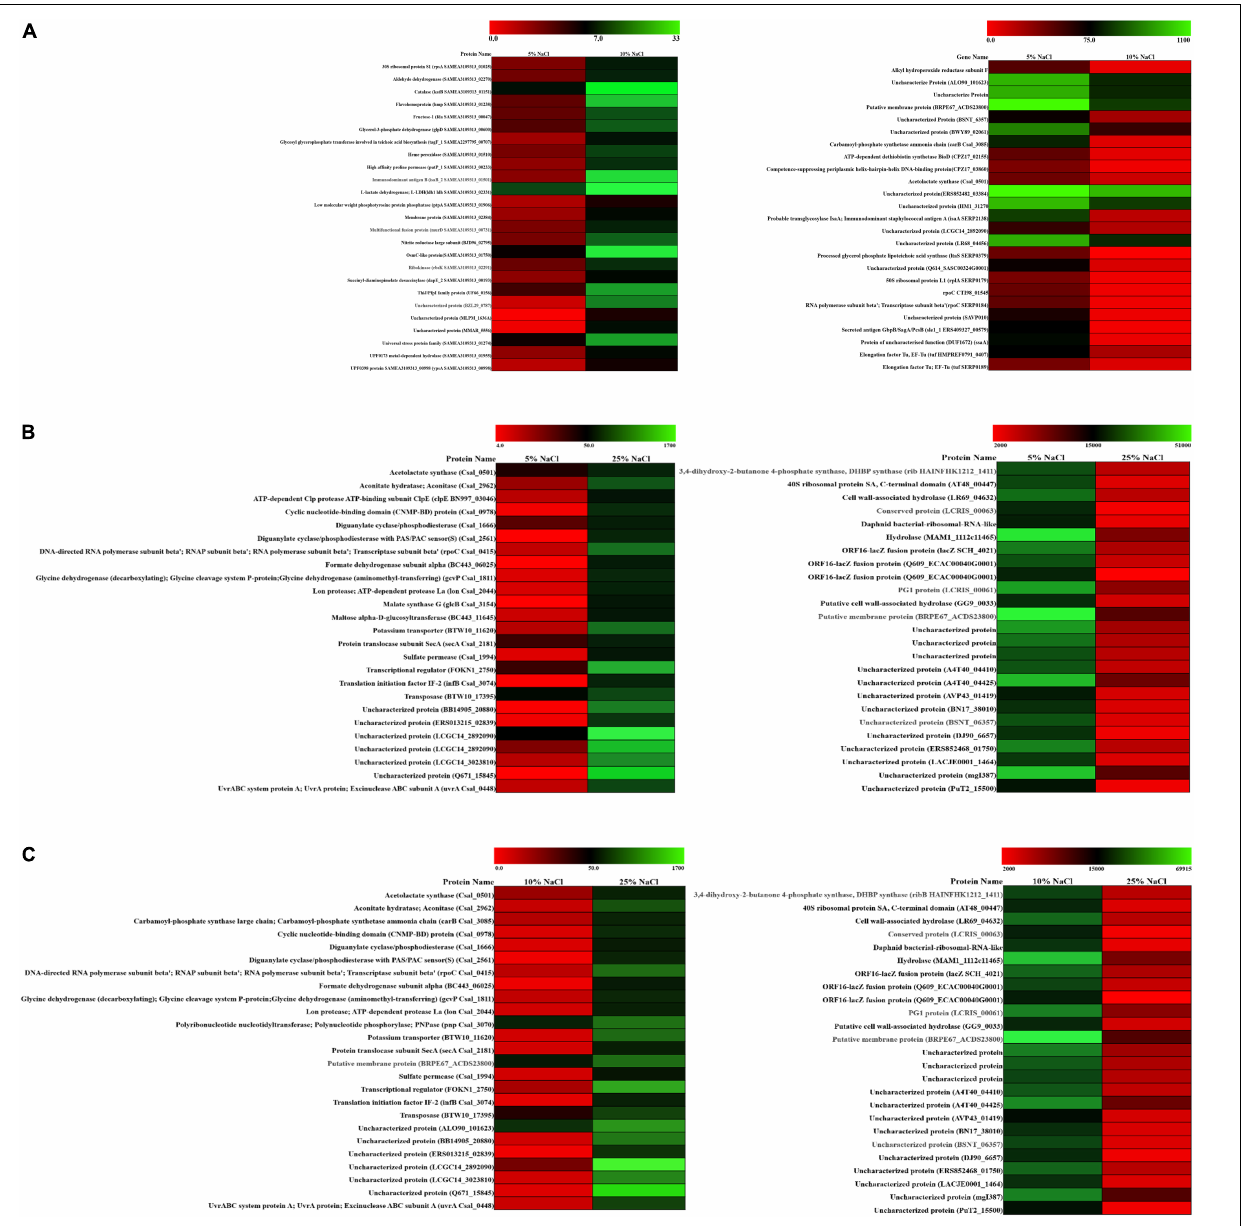
FIGURE 3 | Differential expression of gene (DEG) analysis of ANJ207. (A) Heatmap of the C1 vs. C2 upregulated and downregulated genes, (B) heatmap of the C1 vs. C3 upregulated and downregulated genes, and (C) heatmap of the C2 vs. C3 upregulated and downregulated genes. Red color indicates no expression while green indicates the highest